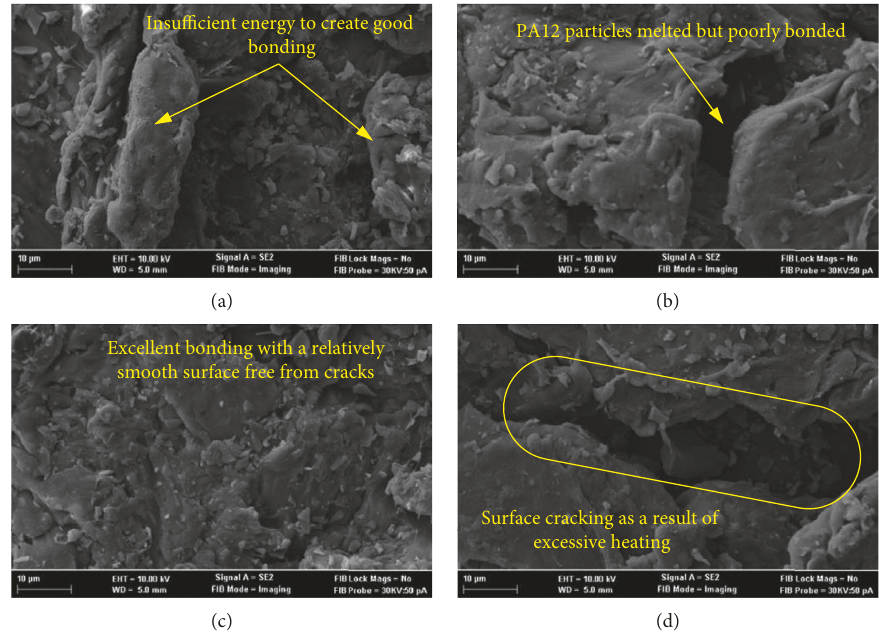
Figure 10: Effect of laser power on surface properties of SLS parts: (a) LP � 5.5watt; (b) LP � 6.5watt; (c) LP � 7.0watt; (d) LP �